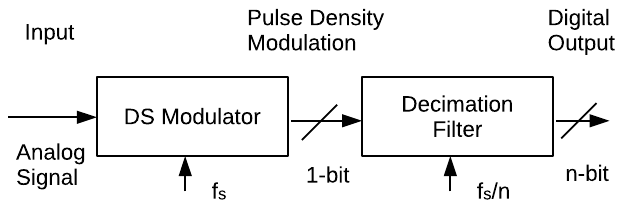
Figure 1. Block diagrma of the delta-sigma